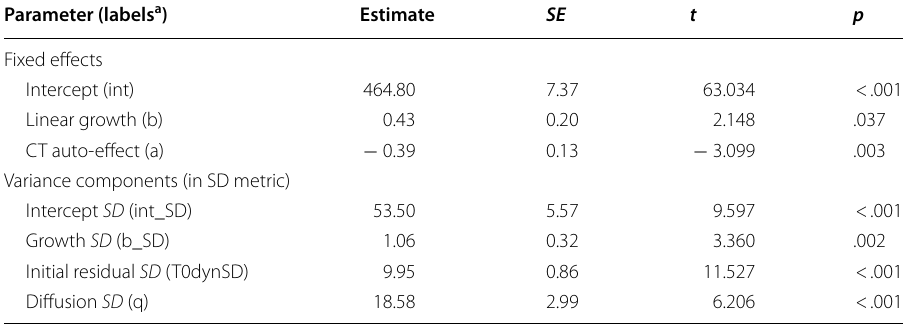
Table 3 Parameter Estimates of the CT-LCM-SR for PISA Countries’ Mean Reading Literacy Scores